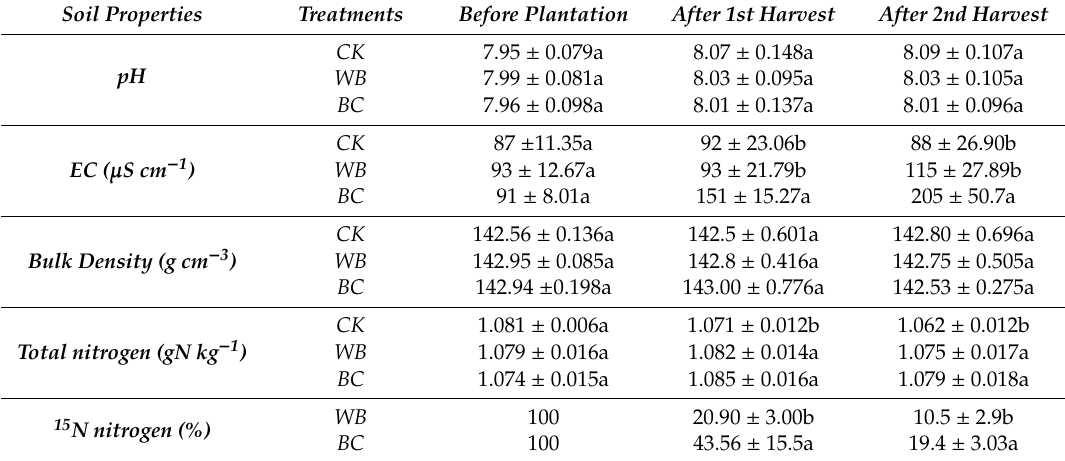
Table 2. Mean values with standard deviation for the soil characteristics of CK (control), WB (without biochar), and BC (biochar added) before and after the first and the second harvest of the Brassica Camprestis Var. Chinensis plantation in lysimeters. The small letters (a, b, c) present the level of significance among the treatments according to the pair-wise Sche ff e